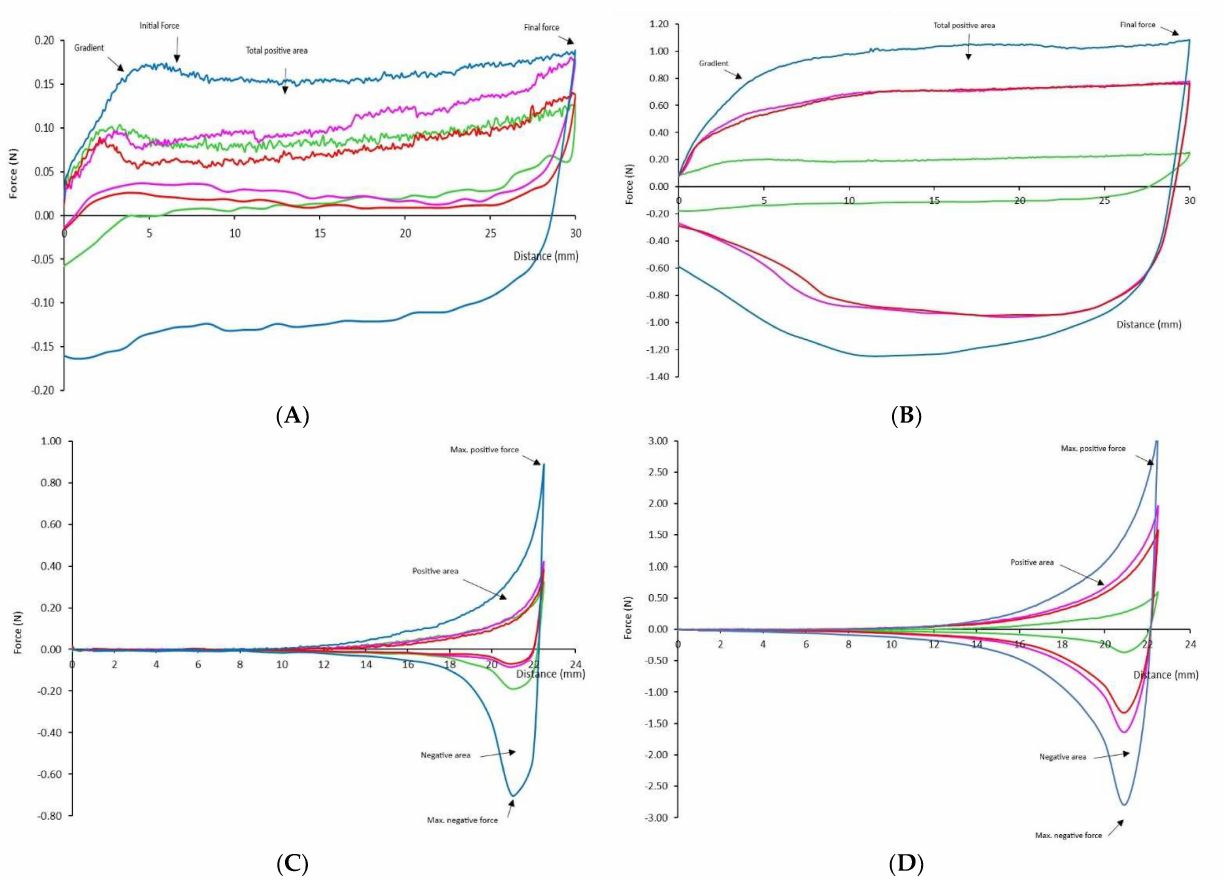
Figure 1. Force–deformation curve of the four thickeners derived from the extrusion test with disc (( A ): nectar, ( B ): pudding) and cone ( C ): nectar, ( D ): pudding) at 1 mm/s. Different colors indicate different thickeners: green—thickener ( A ), pink—thickener ( B ), red—thickener ( C ), and blue—thickener ( D